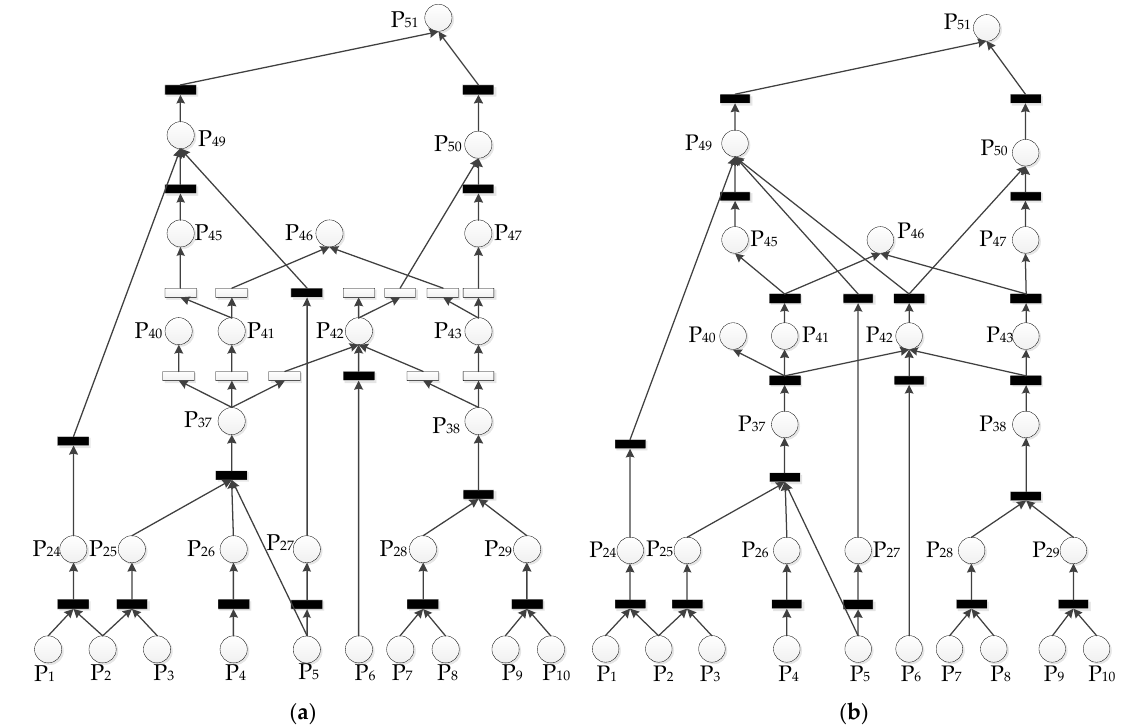
Figure 6. The model of bearing fault. ( a ) Fault-diagnosis model based on FPN; ( b ) fault-diagnosis model based on CLPSO-FPN. model based on